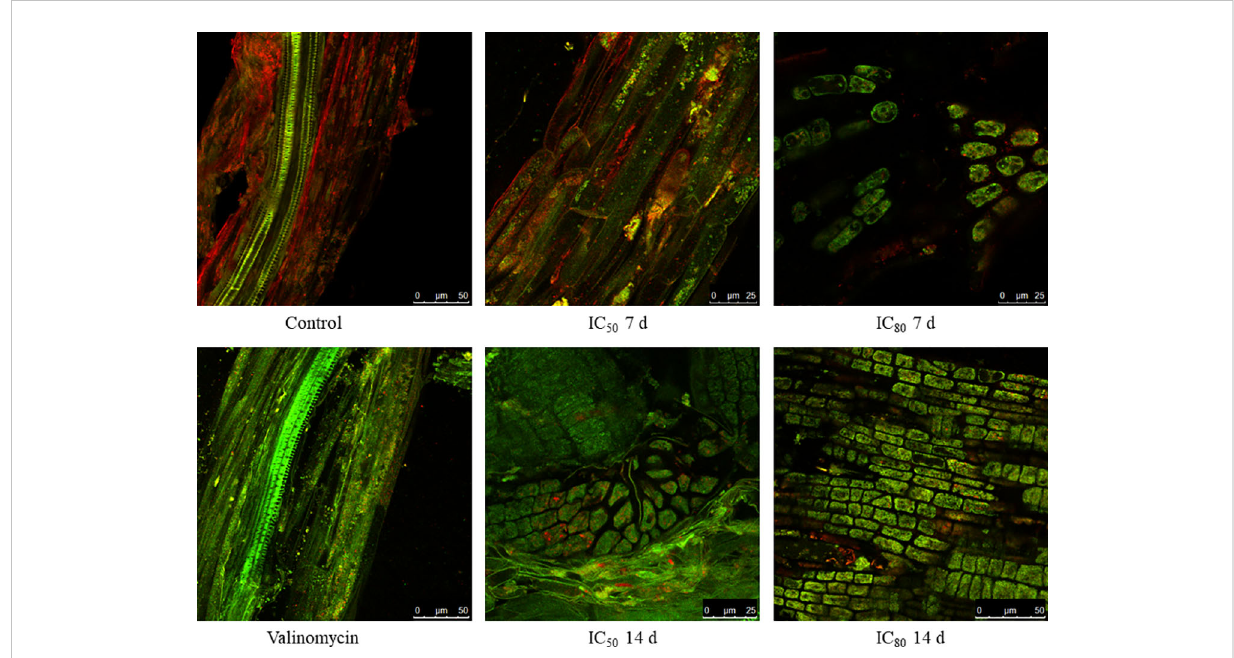
m M PCIB, (E) 15 m M PCIB + IC m M PCIB + IC 50 TC, (C) IC 80 TC, (D) 15 50 TC, (F) 15 80